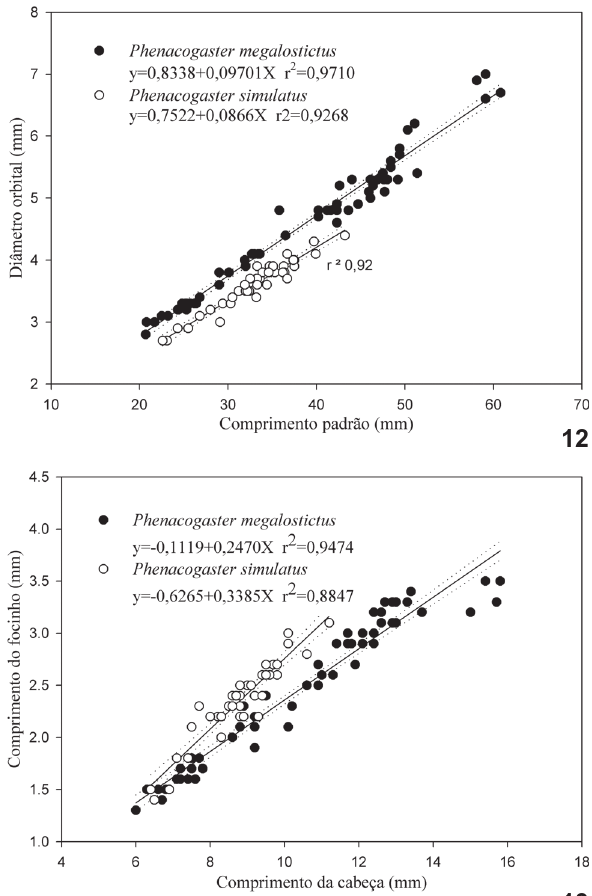
Figuras 12-13. (12) Regressão linear do diâmetro orbital sobre o comprimento padrão em Phenacogaster megalostictus e P. simulatus ; (13) regressão linear do comprimento do focinho sobre o compri- mento da cabeça em P. megalostictus e P. simulatus . Linhas tracejadas indicam o intervalo de confiança de